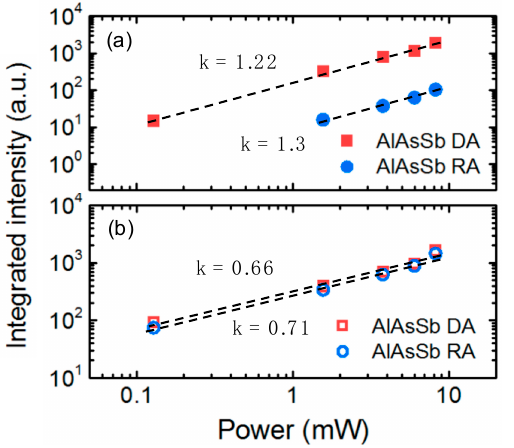
Figure 5. PL peak energies of ( a ) E X peak and ( b ) DL peak for both DA and RA samples as a function of laser excitation power.